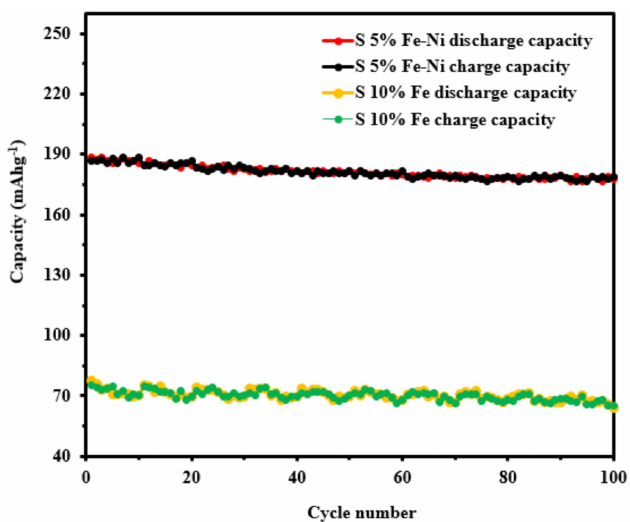
Figure 8. Cycling stability of the S5% Fe-Ni and S10% Fe samples at the current rate of 1